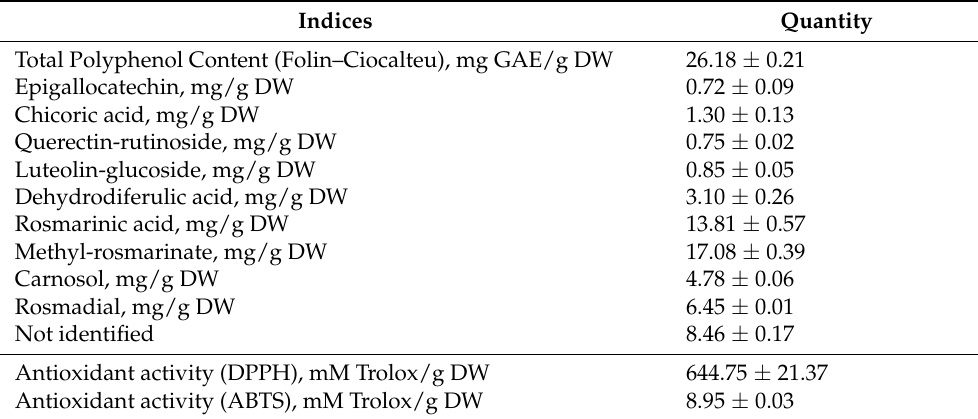
Table 1. The content of total and individual polyphenols and the antioxidant activity of basil extract used for